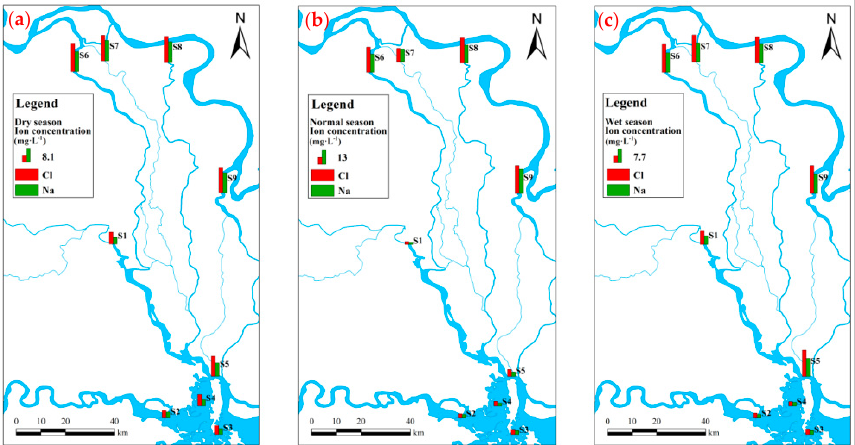
Figure 4. Spatiotemporal distribution of the concentrations of Na + and Cl – in the dry season ( a ), in the normal season ( b ) and in the wet season ( c ), respectively. In the legend, the length of the green bar represents the unit length.